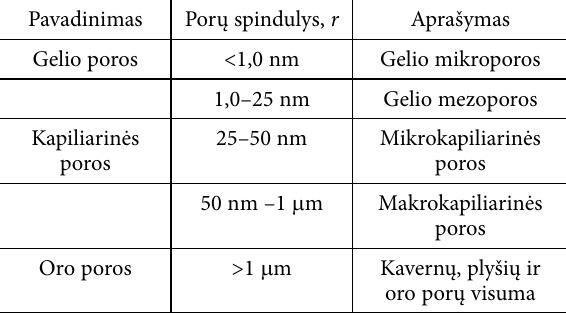
Table 4. The distribution of concrete pores (IUPAC) Pavadinimas Porų spindulys, r Aprašymas Gelio poros <1,0 nm Gelio mikroporos 1,0–25 nm Gelio mezoporos Kapiliarinės 25–50 nm Mikrokapiliarinės poros poros 50 nm –1 m m Makrokapiliarinės poros Oro poros >1 m m